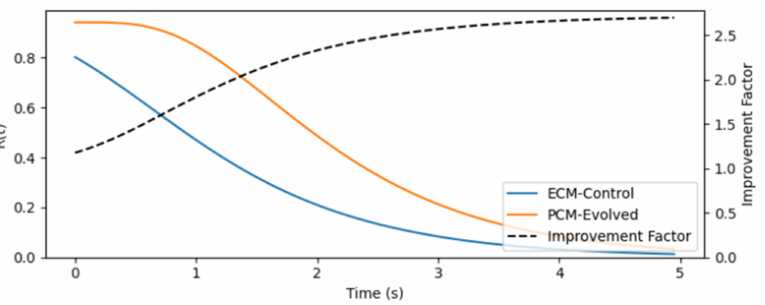
Figure 32. LSSE output for the MTBRF and Reliability Improvement Factor of an experiment with 1000 MASs, with initial failure states permitted, with 3 tasks and 5 agents in each MAS.